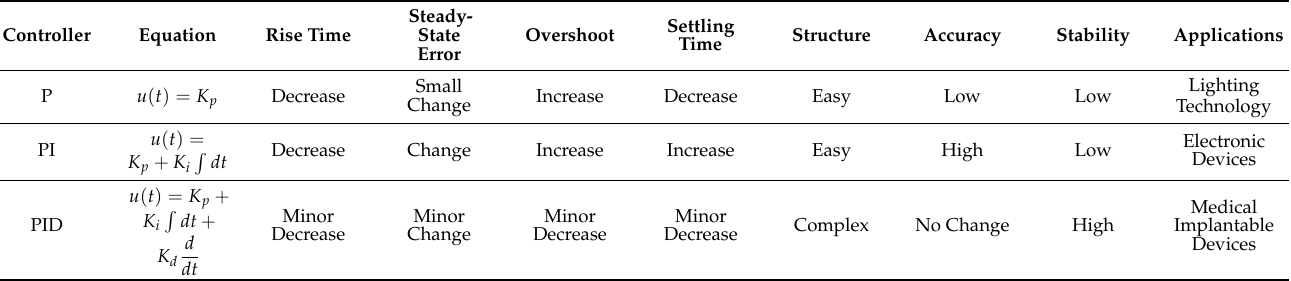
Table 10. Comparison of Classic